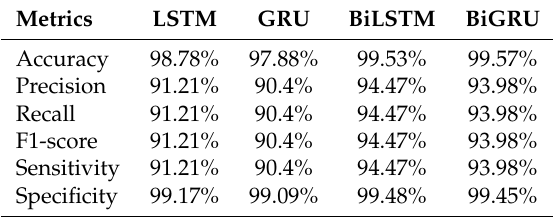
Table 7. Performance evaluation results for the simple